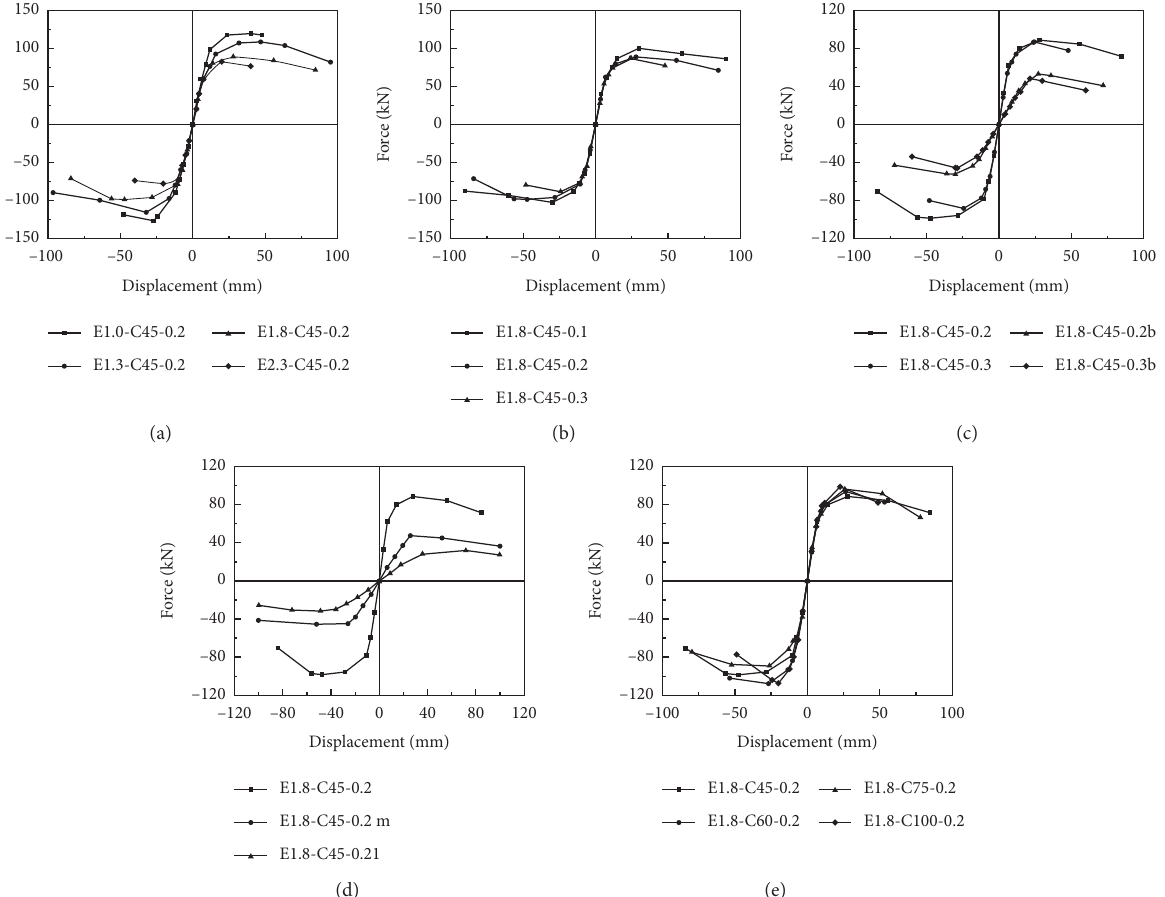
Figure 10: Skeleton cures of test specimens. (a) Variation of aspect ratio. (b) Variation of axial compression ratio. (c) Variation of bending axis. (d) Variation of slenderness ratio. (e) Variation of concrete strength.